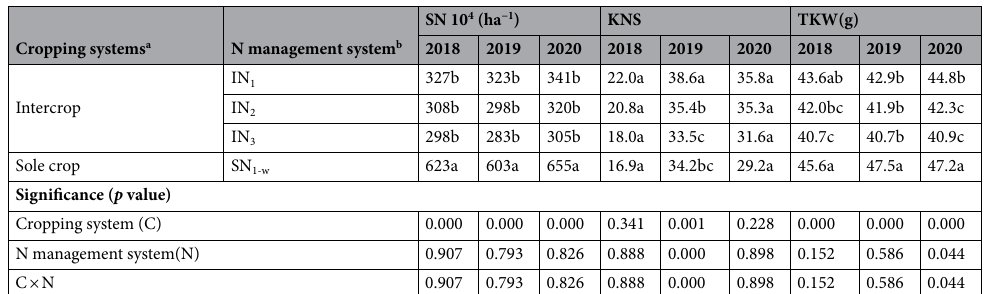
Table 3. The spike number (SN), kernel number per spike (KNS), and thousand-kernel weight (TKW) of wheat in sole crop and intercrop as affected by cropping system and N management in 2018–2020. Means with the same lowercase letters in the same column are significantly different at P ≤ 0.05. a Intercrop and sole crop means the intercropped wheat and sole wheat. b For intercropping, N 1 , N 2 , and N 3 represent N-fertilizer applied at 51, 72, and 93 kg N ha −1 as first top-dressing plus 63, 42, and 21 kg N ha −1 at third top-dressing, respectively. For sole cropping, N 1 represents N-fertilizer applied at 108 kg N ha −1 as base fertilizer plus 72 kg N ha −1 at top-